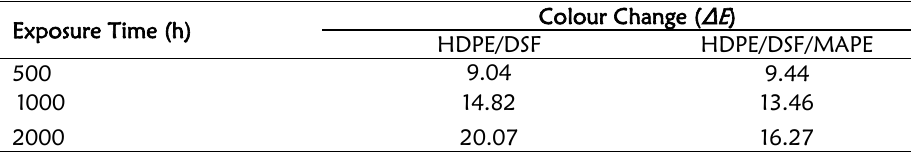
Table 2: ∆E at various exposure